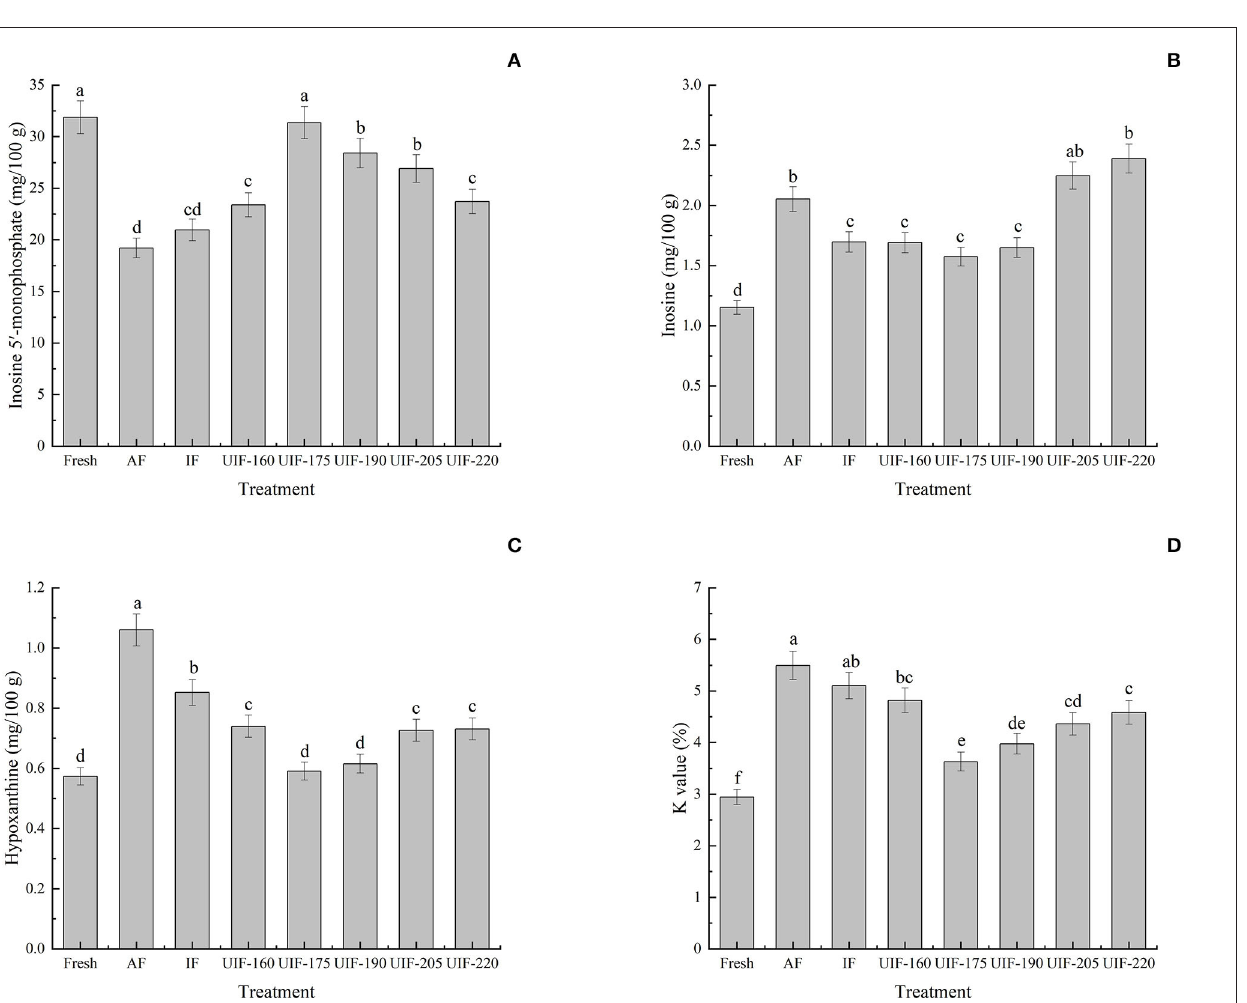
Frontiers in Nutrition |